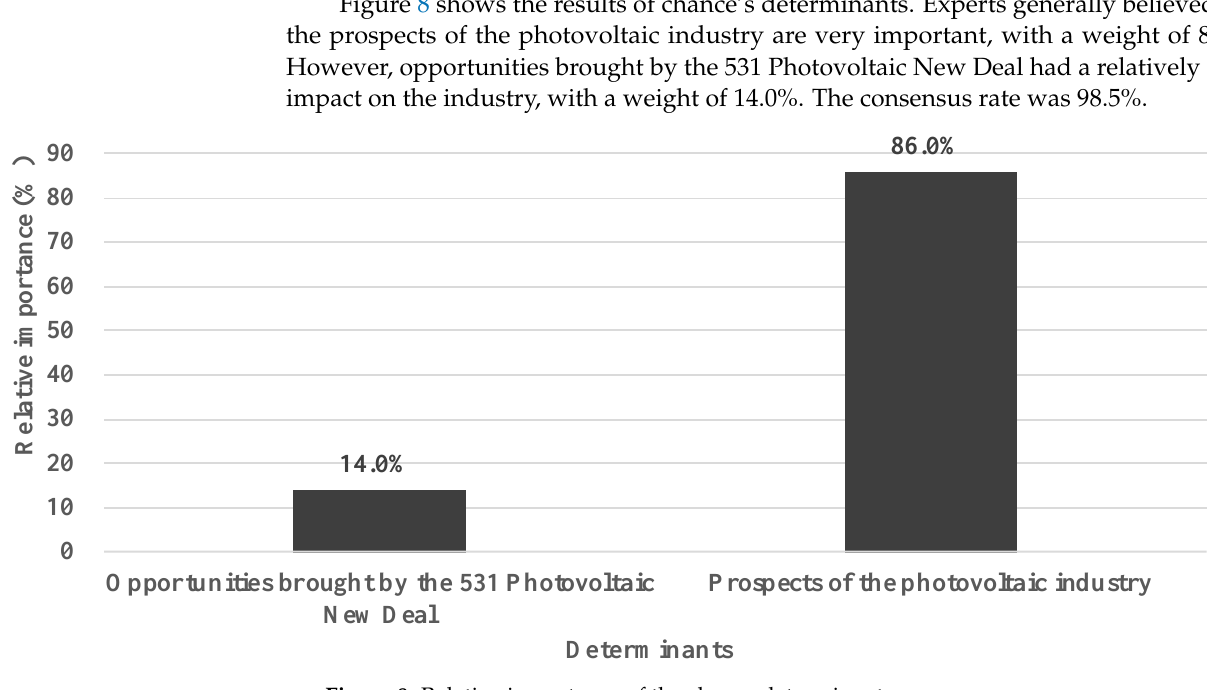
Figure 8. Relative importance of the chance determinants.